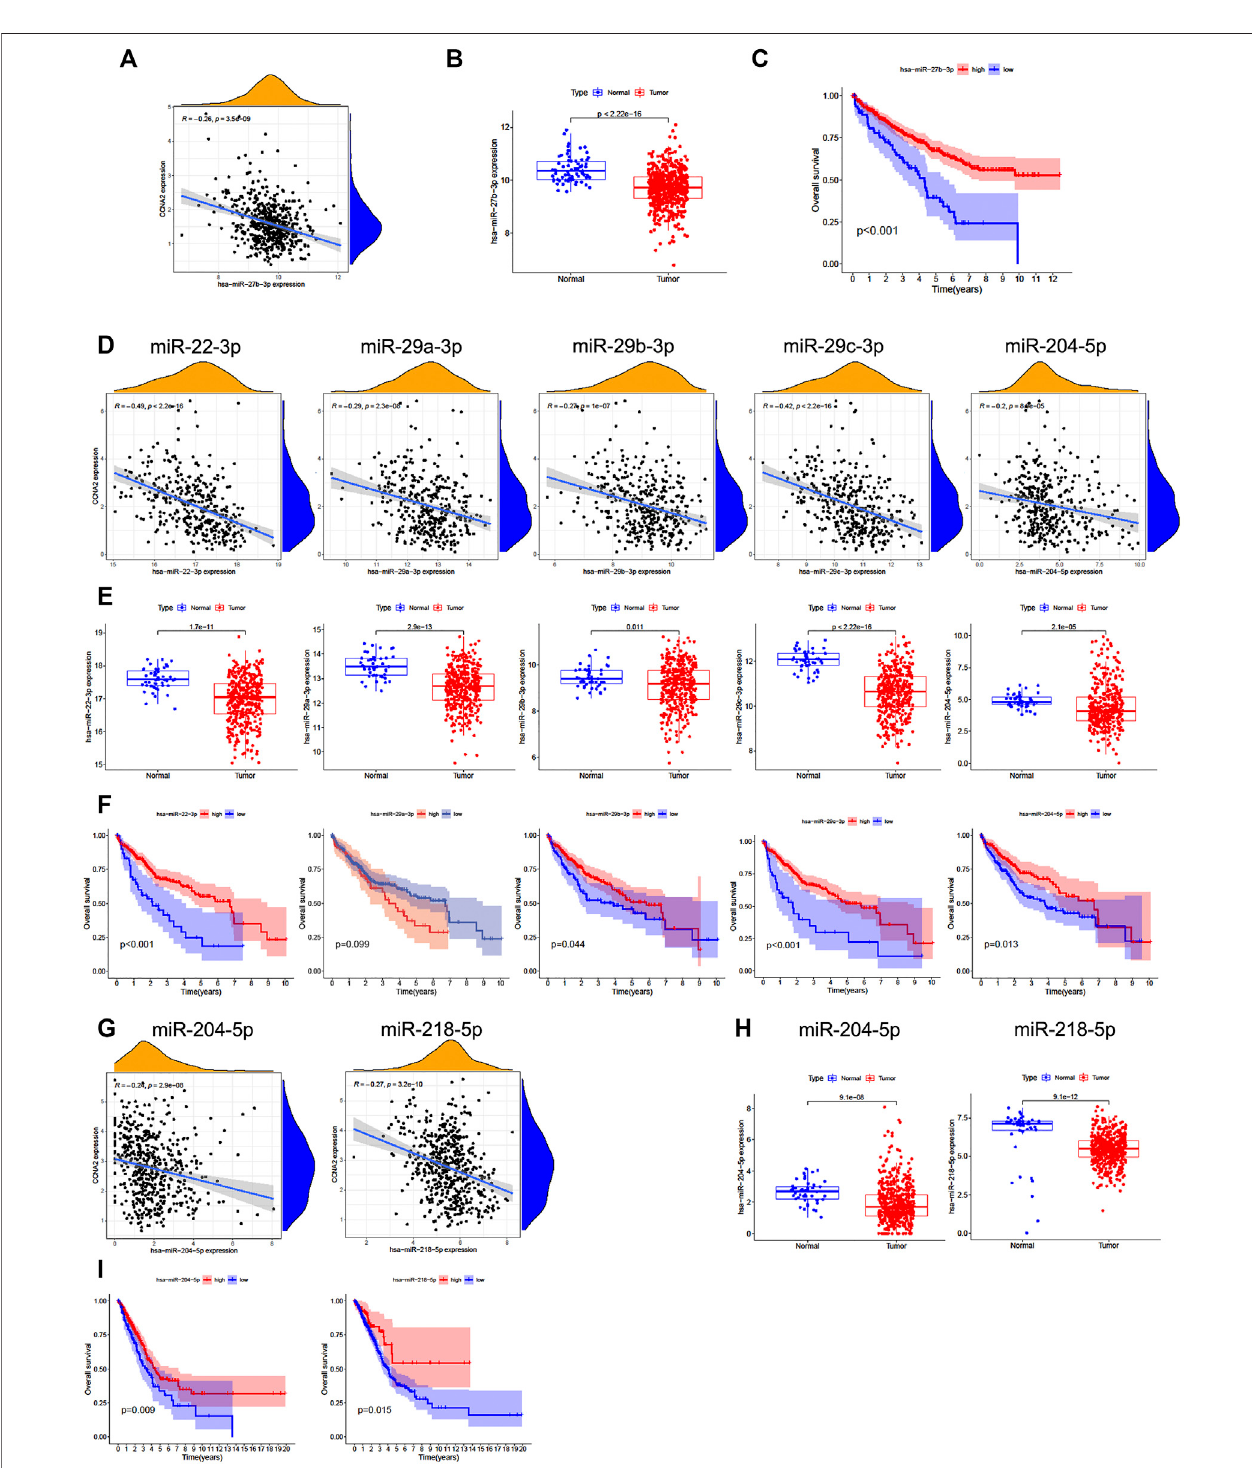
FIGURE 4 | Predictive analysis of upstream miRNA of CCNA2. MicroRNA expression was shown as log2 (miRNA+1). (A) The negative correlation between miR- 27b-3pandCCNA2inKIRC. (B) TheexpressionofmiR-27b-3pinKIRCandnormaltissues(num(T)=545;num(N)=71). (C) OverallsurvivalanalysisbasedonthemiR- 27b-3p expression in KIRC. (D) The negative correlation between miRNAs (miR-22-3p, miR-29c-3p, miR-29a-3p, miR-29b-3p, and miR-204-5p) and CCNA2 in LIHC. (E) TheexpressionofmiRNAs(miR-22-3p,miR-29c-3p,miR-29a-3p,miR-29b-3p,andmiR-204-5p)inLIHCandnormaltissues(num(T)=375;num(N)=50). (F) Overall survival analysis based on expression of miRNAs (miR-22-3p, miR-29c-3p, miR-29a-3p, miR-29b-3p, and miR-204-5p) in LIHC. (G) The negative correlation betweenmiRNAs(miR-204-5p and miR-218-5p) and CCNA2 inLUAD. (H) Theexpression ofmiRNAs (miR-204-5p and miR-218-5p) inLUAD and normal tissues (num (T) = 521; num (N) = 46). (I) Overall survival analysis based on the expression of miRNAs (miR-204-5p and miR-218-5p) in LUAD.